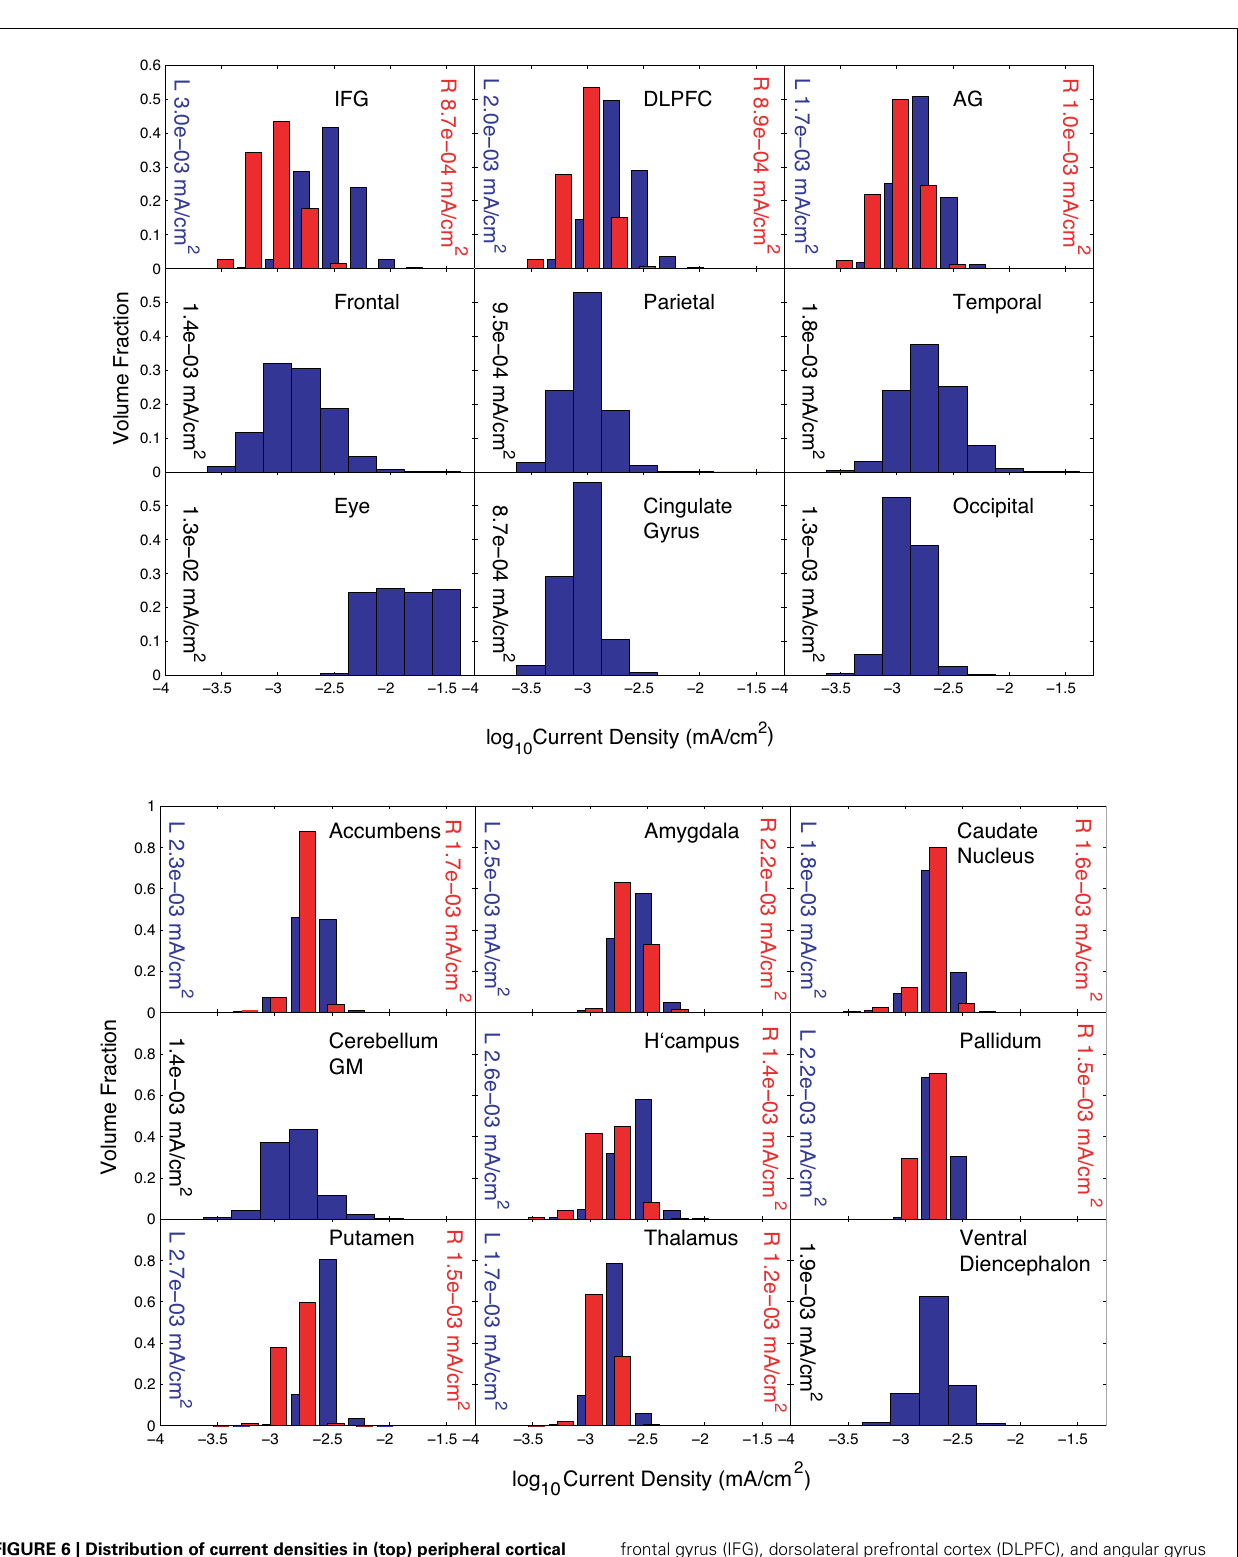
FIGURE 6 | Distribution of current densities in (top) peripheral cortical structures and (bottom) deep brain structures for Problem 2. Median values in each structure obtained using the optimal solution X are shown within each graph of the figure. IFG, DLPFC, and AG refer to the inferior